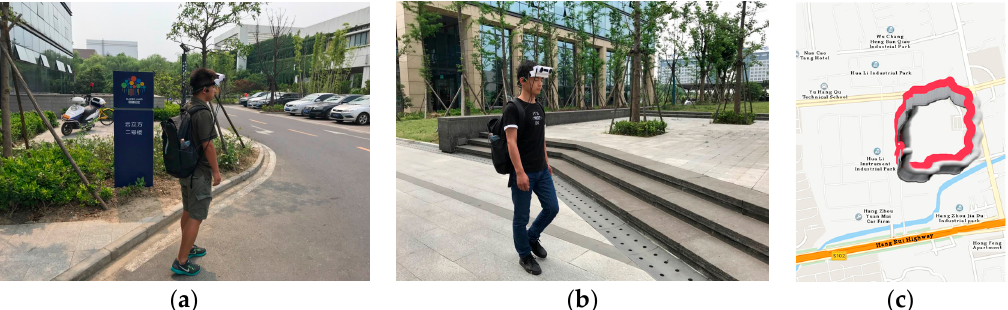
Figure 14. ( a , b ) The voluntary participants wearing the assisting prototype including a pRGB-D sensor, a laptop in the backpack and a set of bone-conduction headphone; ( c ) The route around a building and an empty field in the real-world environment while the red labels represent the locations during navigation.